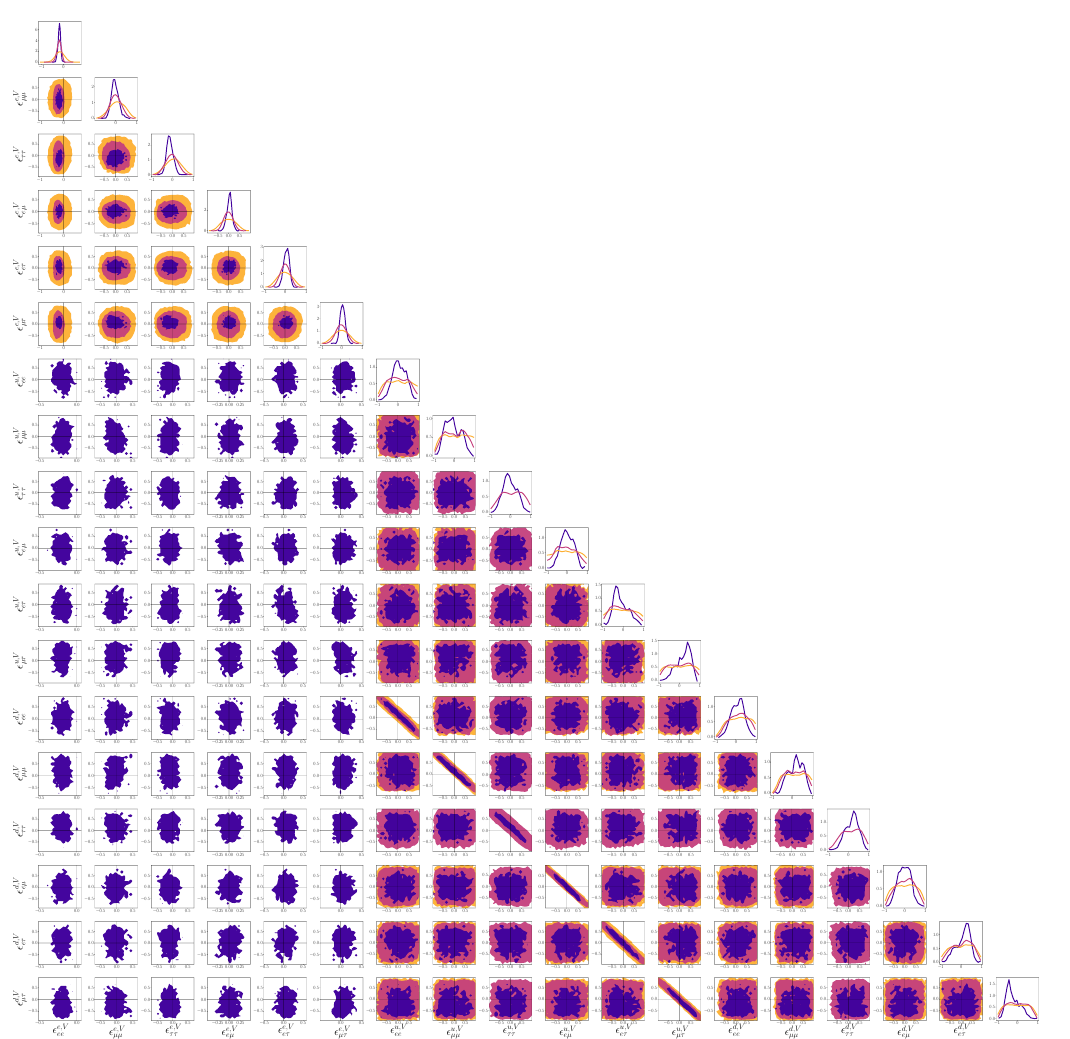
Figure 10 . 1-dimensional marginals and 95% credible contours for the 2-dimensional marginal projections are shown for (cid:15) e;V , (cid:15) u;V , and (cid:15) d;V for a total of 18 NSI degrees of freedom. The (cid:12)rst (cid:11)(cid:12) (cid:11)(cid:12) (cid:11)(cid:12) stage (yellow) consists of COHERENT and Borexino. The second stage (magenta) consists of the future LXe projection for atmospheric neutrinos and solar neutrinos and takes in priors from the (cid:12)rst stage. The (cid:12)nal result at the last stage (indigo) uses atmospheric neutrinos at DUNE and takes in priors from the second